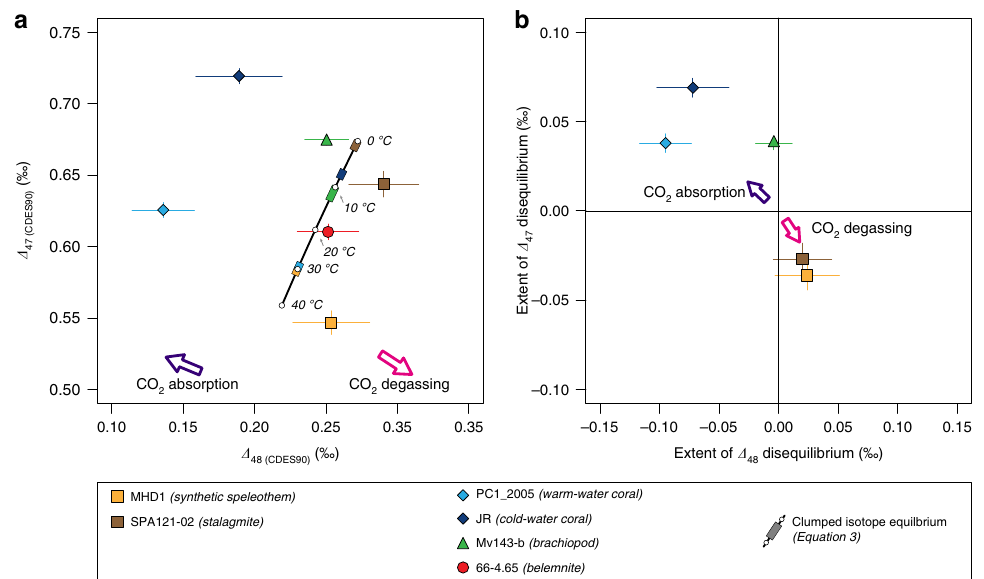
Fig. 2 The nature and extent of kinetic isotope effects in representative carbonates. a The isotopic compositions of the stalagmite, synthetic speleothem, cold-water coral, warm-water coral, and the brachiopod deviate signi fi cantly from their respective equilibrium compositions (coloured rectangles on the equilibrium line), while the belemnite is indistinguishable from the equilibrium line. b The cold- and warm-water corals show positive Δ 47 (CDES90) offsets and negative Δ 48 (CDES90) offsets from the thermodynamic equilibrium, which are consistent with kinetic effects derived from CO 2 absorption (purple arrow). In comparison, the stalagmite and the synthetic speleothem show negative Δ 47 (CDES90) offsets and positive Δ 48 (CDES90) offsets that are consistent with kinetic effects derived from CO 2 degassing (pink arrow). Disequilibrium offsets were calculated relative to the equilibrium Δ 47 (CDES90) and Δ 48 – 3)). All error bars depict 2 standard errors (95% con fi dence (CDES90) values expected at the corresponding carbonate growth temperatures (Eqs. (1 interval 35